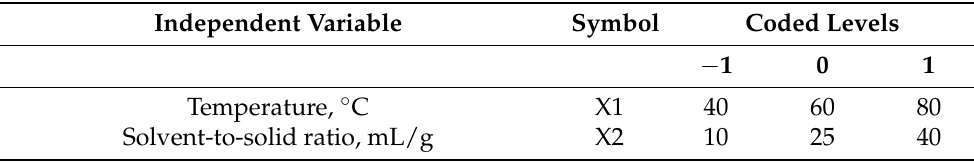
Table 1. Independent variables and their coded and actual values used for